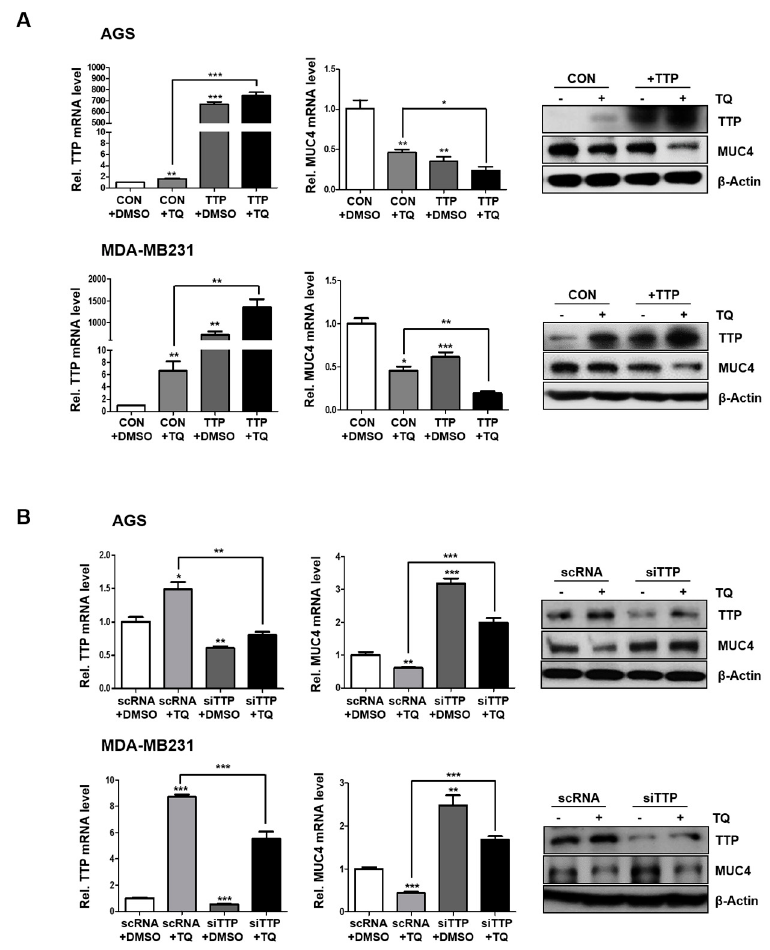
Figure 2. MUC4 expression is down-regulated by TTP expression in gastric and breast cancer cells. ( A ) Detection of MUC4 mRNA and protein in AGS and MDA-MB231 cells with transfected pcDNA6 / V5 or pcDNA6 / V5-TTP. ( B ) MUC4 mRNA and protein levels increased through inhibition of TTP. β -actin was detected as a loading control for qRT-PCR and western blotting. Each bar represents the mean ± S.D. of three independent experiments. * p < 0.05; ** p < 0.01; *** p < 0.001.